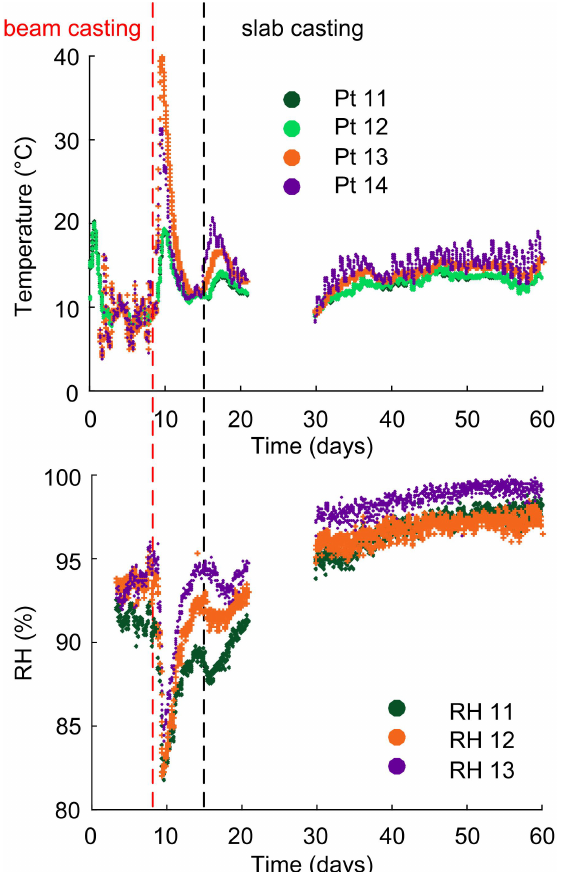
Figure 14. Temperature and relative humidity measured in beam 1 during the first two